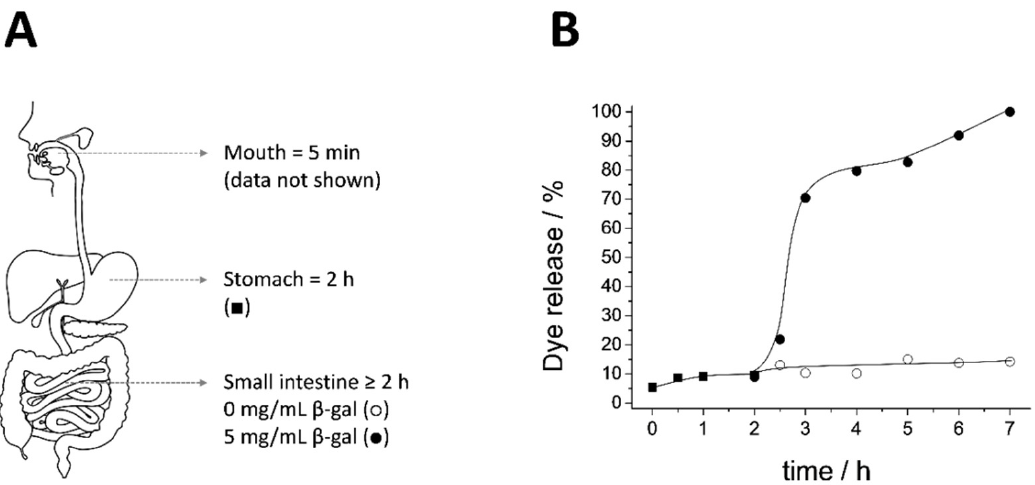
Figure 4. ( A ) Biofluid digestion scheme and retention times. ( B ) Biofluid digestion release profiles from M41-RhB-L in simulated gastric ( ), and intestinal fluids in the absence ( ) or in the presence of β -gal at a concentration of 5 mg/mL ( ).